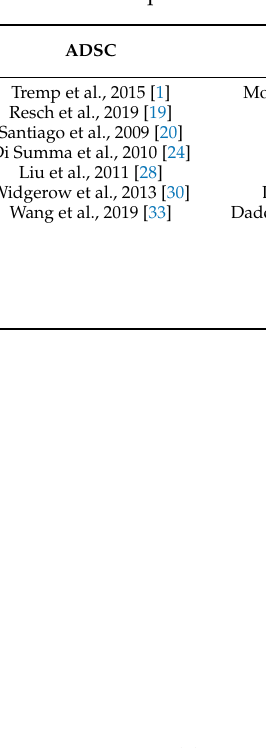
Table 2. Mesenchymal stem cells (MSCs) characteristics. Adapted from Cofano et al., 2019